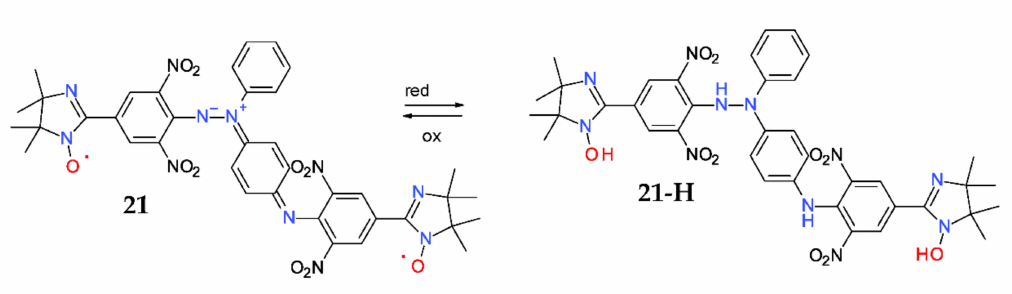
Figure 12. Reversible oxidation or reduction of betaine